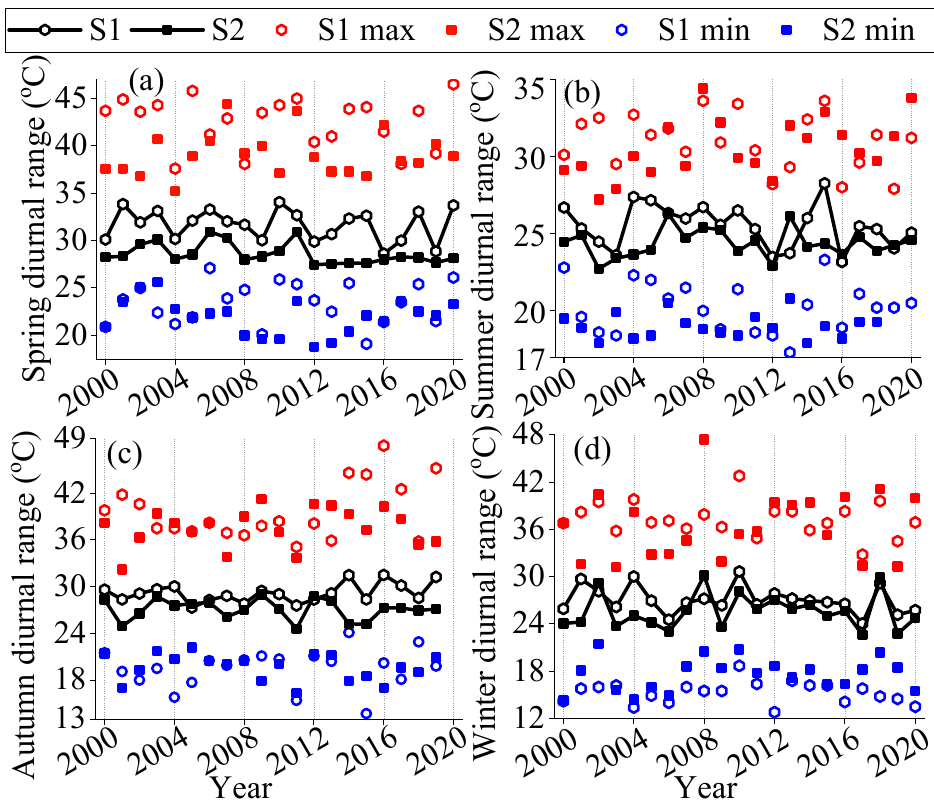
Figure 4. Seasonal variation trend of diurnal temperature range, ( a ): spring, ( b ): summer, ( c ): autumn, ( d ): winter. The red and blue scatter points represent the maximum and minimum of the daily range; S1 and S2 represent two regions of the study area.